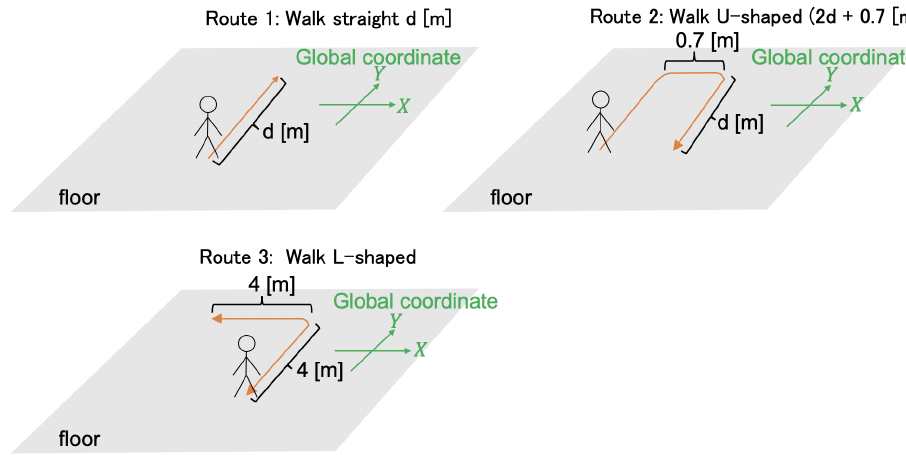
Figure 13. The walking routes of Experiment 2.